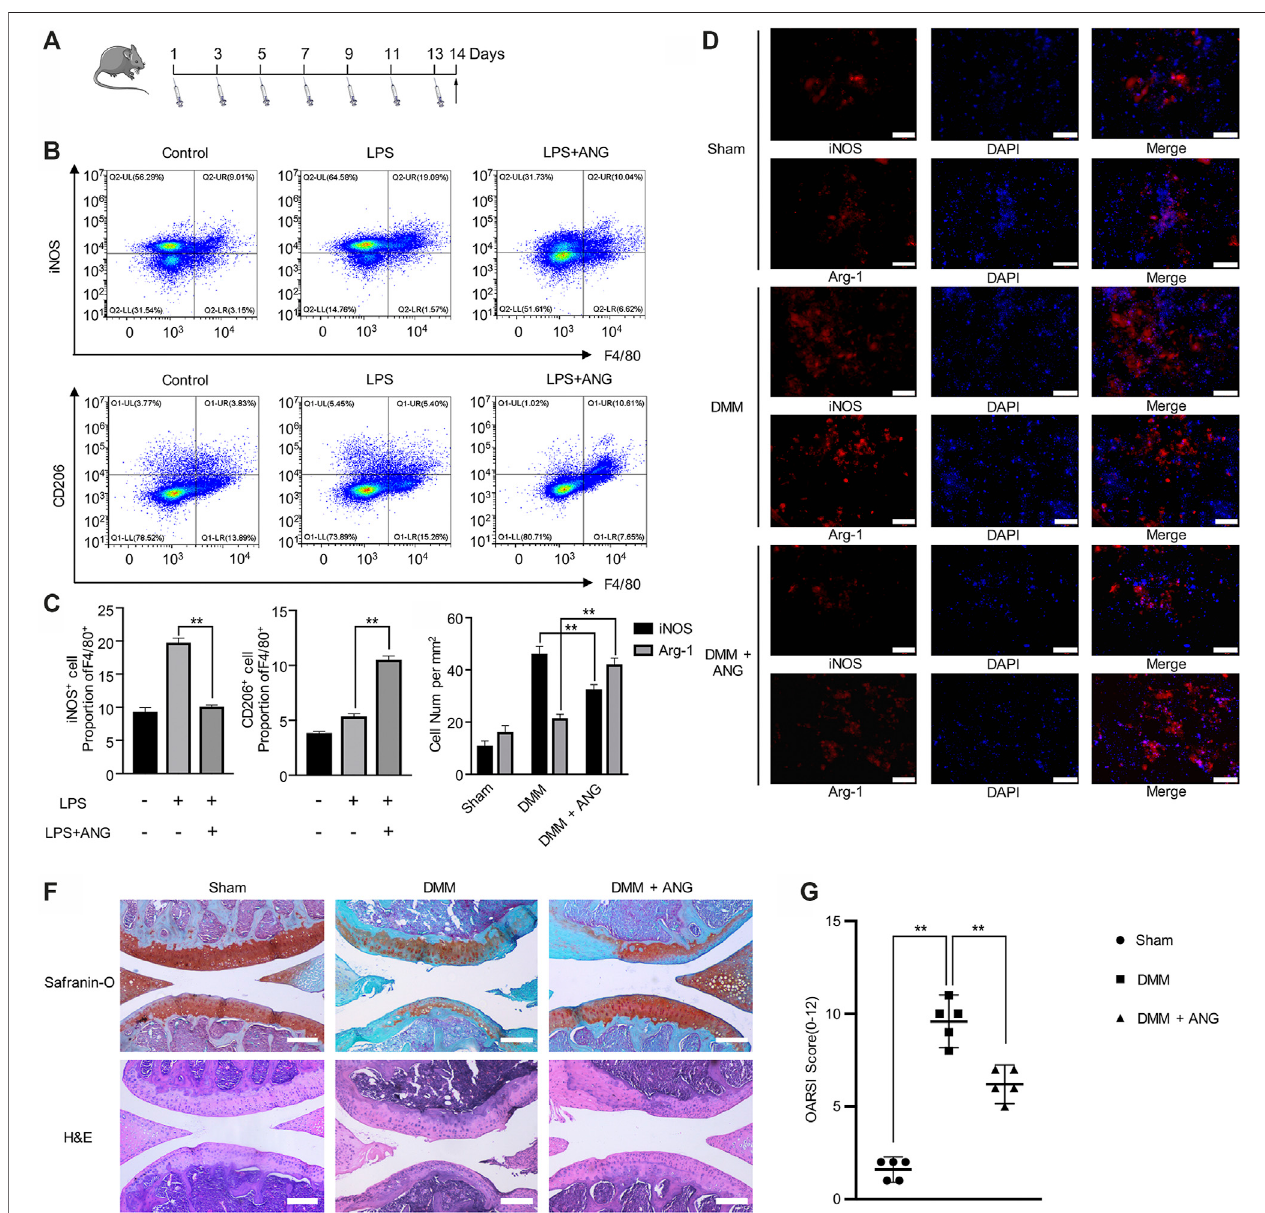
FIGURE 4 | Angelicin alleviates PTOA development by regulating M1/M2 polarization. (A) Experiment design of treatment on LPS-induced mice. (B, C) Flow cytometry analysis of iNOS + F4/80 + and CD206 + F4/80 + macrophage in total bone marrow cells. (D, E) Immunostaining of iNOS and CD206 (red) in DMM model. Bar represents200 μ m. (F) RepresentativeSafranin-OstainingandH&Estainingofcartilageandarticulartissuesfromthedifferentexperimentalgroups(scalebar (cid:2) 50 µm). (G) Diagram showing the OARSI scores of the articular cartilage.